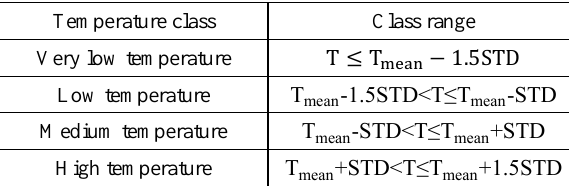
Table 2. Classification of the surface temperature